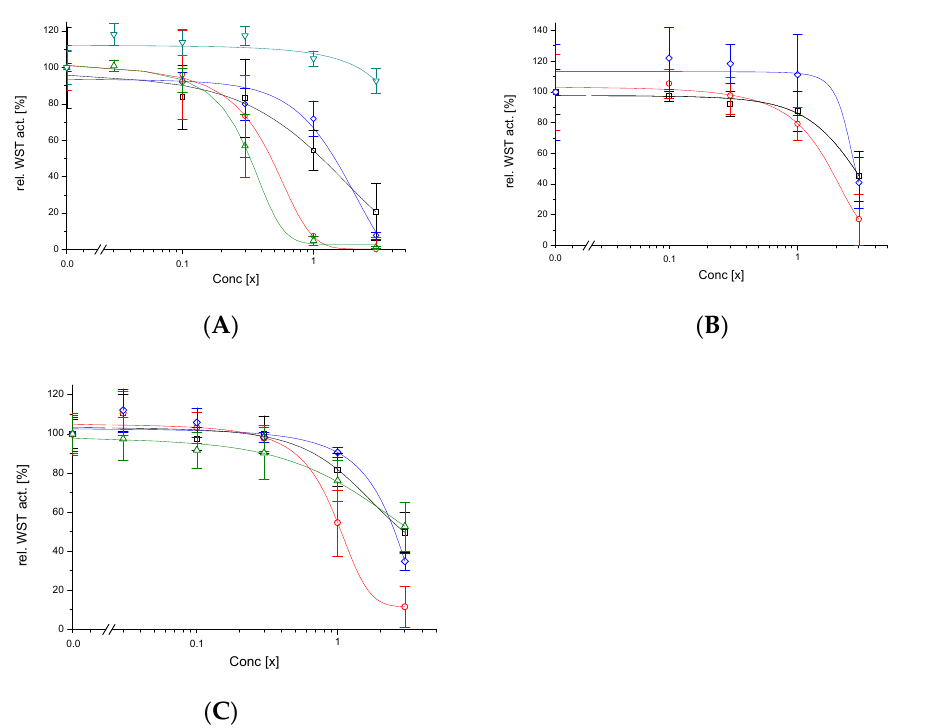
Figure 3. Estimation of cytotoxicity by measuring metabolic activity of HT-29 after being exposed for 24 h to differently treated Aloe fillets: dehydrated DAG ( A ), pasteurized PAG ( B ), AIRs AAG ( C ). Samples treated at 60 °C (black square), 80 °C (red circle), 100 °C (blue diamond), ILF (green up-triangle) or ILL (cyan down-triangle). The growth control (0×) was set to 100%, the value of the positive control (20 mm H 2 O 2 ) with 0.24 ± 0.96 is not shown. Error bars indicate SEM × 1.96.